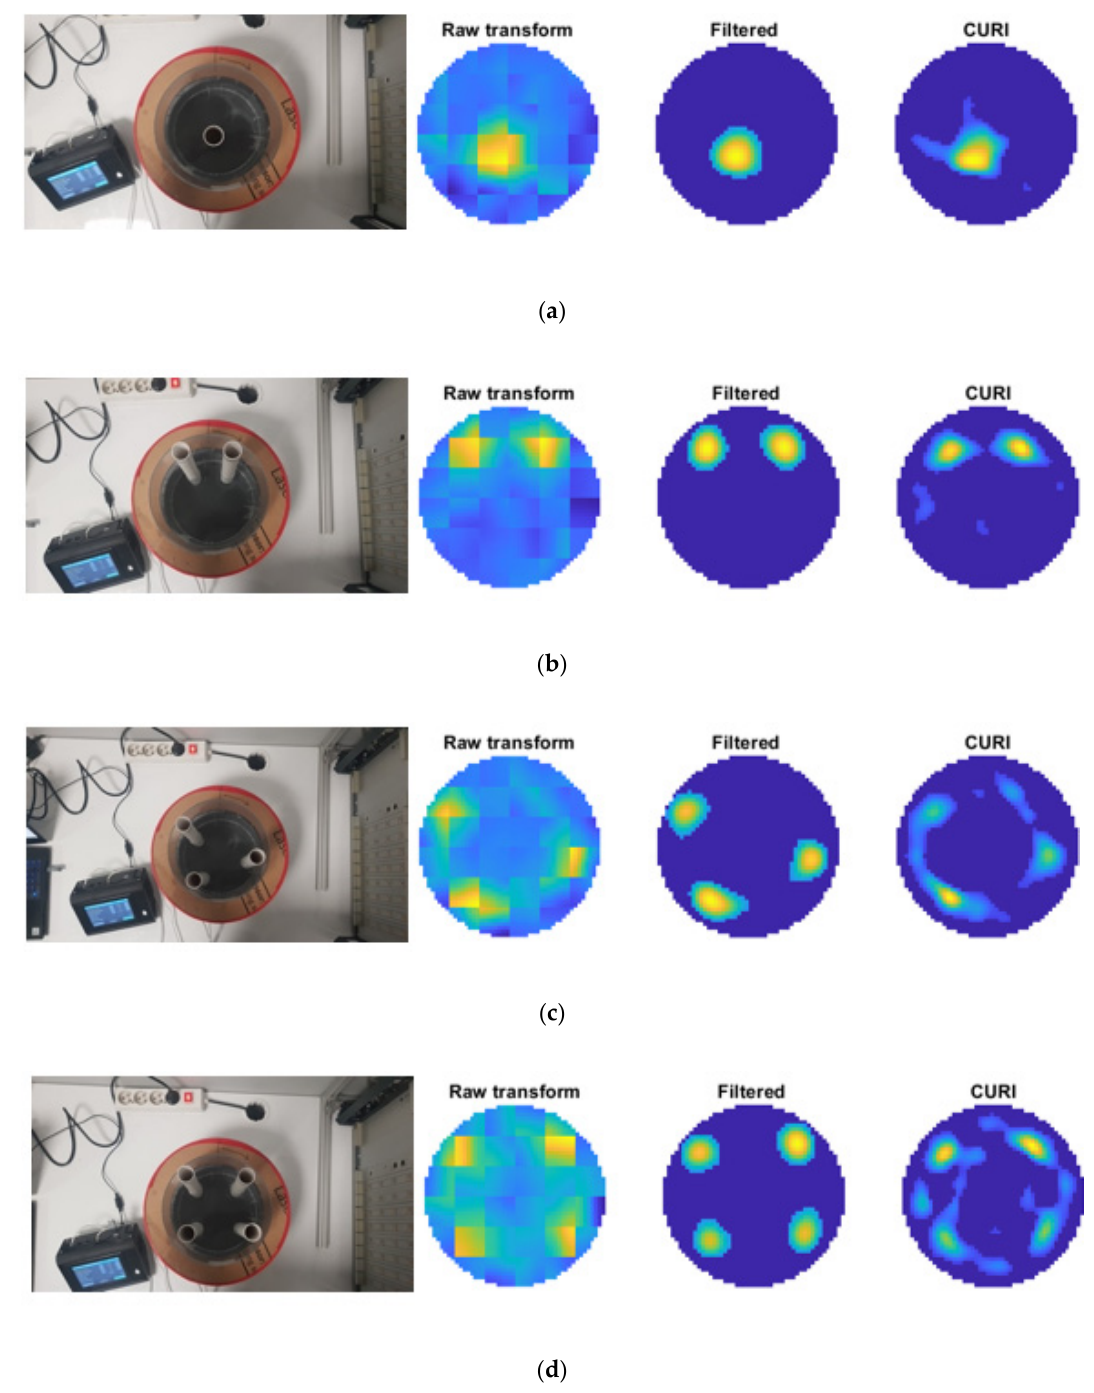
Figure 16. Measurement system and examples of the image reconstruction for ( a ) 1 object, ( b ) 2 objects, ( c ) 3 objects, and ( d ) 4 objects using UST.